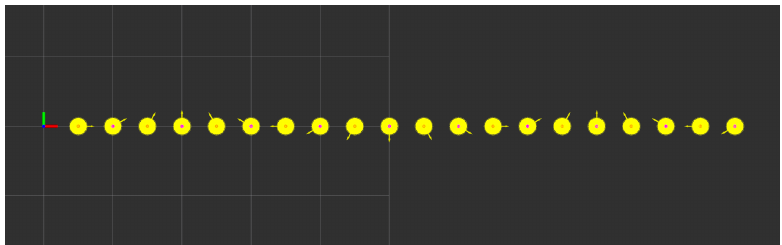
Figure 10. Perceived objects within the local frame of the sensing ITS-S. The objects are a mixture of static pedestrians and vehicles that are placed in a line along with the x direction of the sensing ITS-S. They are perceived with the same location and heading uncertainties in the simulation. The 95% confidence ellipse for the 2D position estimate of each perceived object is shown in yellow. Each grid in every figure represents an area of 10 × 10